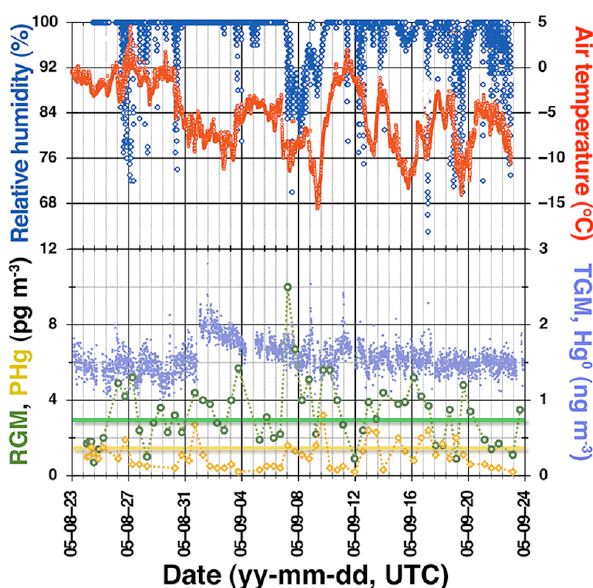
Figure 7 . Concentrations of airborne speciated mercury (TGM, Hg 0 ; RGM and PHg, in lower panel) and some air parameters (temperature and relative humidity, in upper panel) measured along the trans-polar route. Drawing the detection limits for RGM (green line) and PHg (yellow line) indicate the sampling data points below MDL.